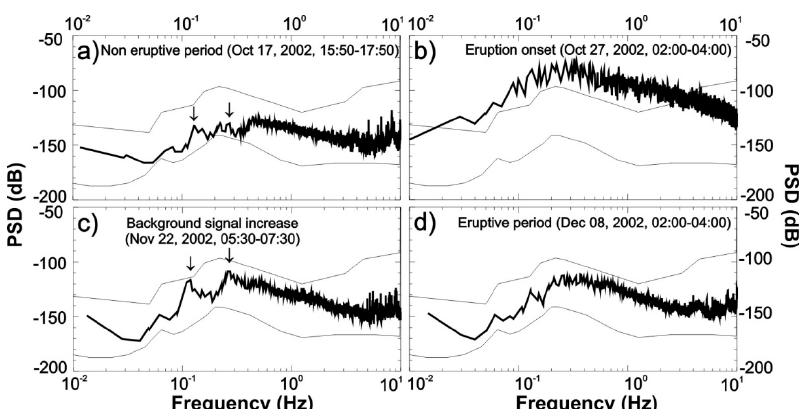
Figure 8. Two-hour-long PSD computed on seismic data. Four different intervals were analysed: ( a ) non-eruptive period (October 17, 2002), ( b ) the eruption onset (October 27, 2002), ( c ) background signal increase not correlated with volcanic activity (November 22, 2002), and ( d ) the eruptive period (December 8, 2002). The two black lines represent the Peterson's reference models [62]. ( b ) Seismic data show the maximum energy content in correspondence of the eruption onset, where the spectral amplitudes exceed the reference model. ( d ) Spectrum computed on the eruptive period is similar in frequency to the previous period but shows lower energy. Their patterns are representative of the volcanic activity. ( a ) The non-eruptive period and ( c ) the background signal increase show a different trend with two microseismic spectral peaks at ~0.1 and ~0.3 Hz, respectively (indicated with black arrows), associated with sea dynamics.